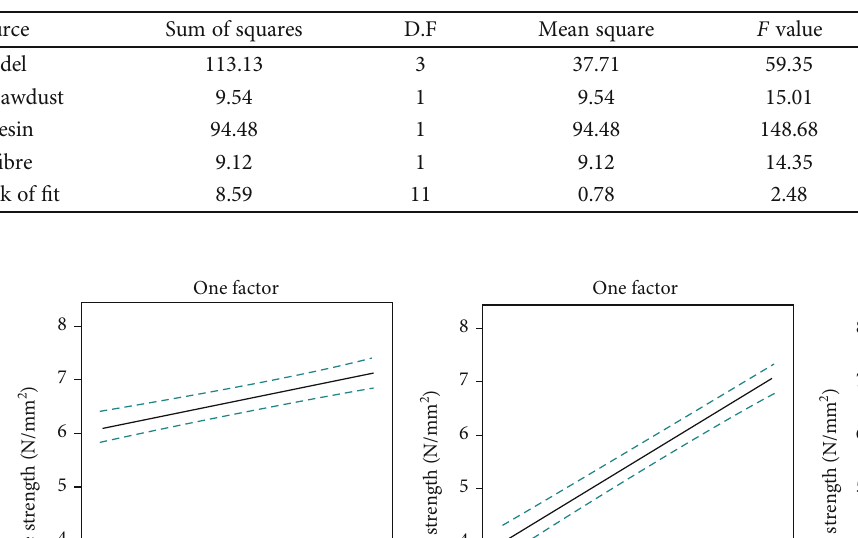
Table 3: ANOVA table for composite tensile